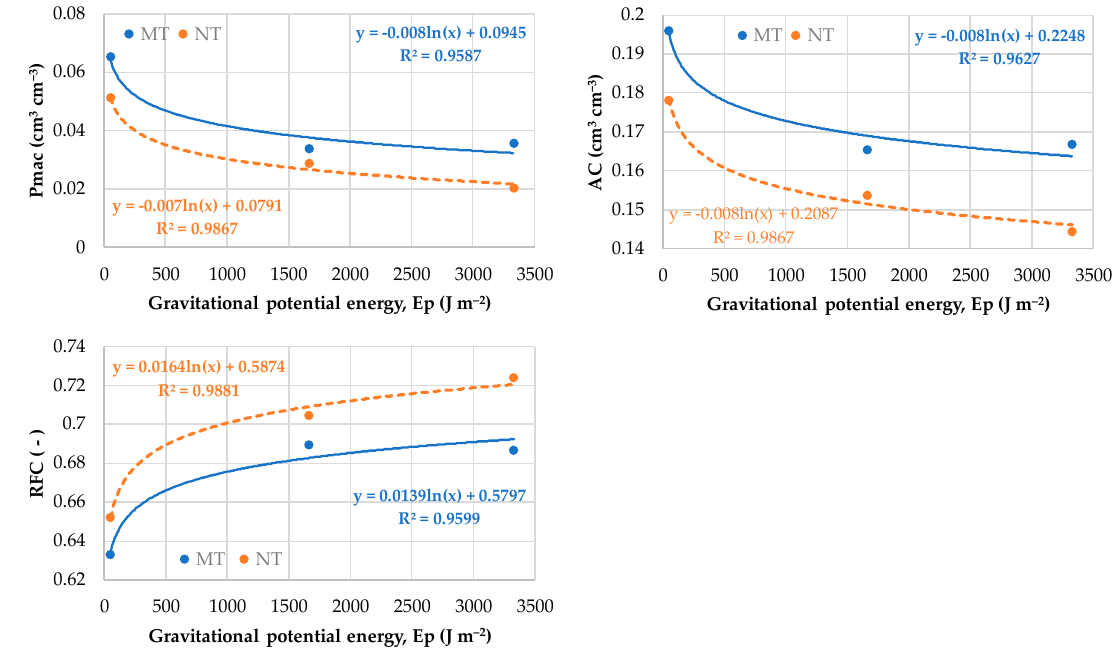
Figure 9. Relationship between the mean values of macroporosity ( Pmac ), air capacity ( AC ) and relative field capacity ( RFC ), and the gravitational potential energy ( E p ) of the water for the two soil management practices (MT and NT).